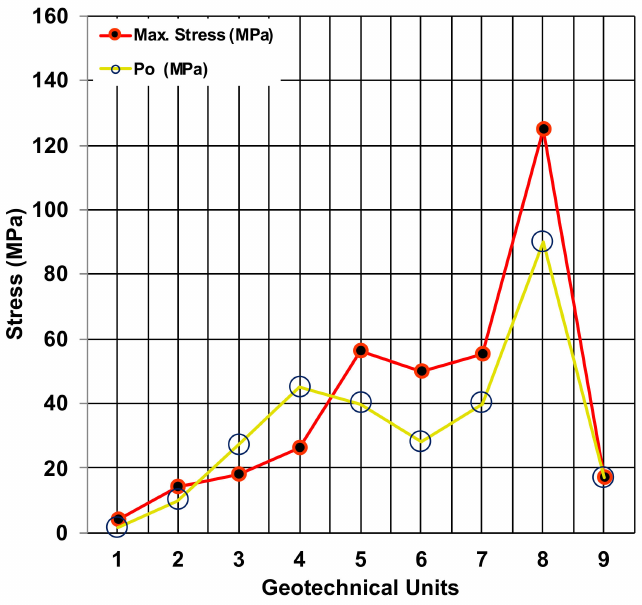
Figure 18. Maximum stress derived from the numerical analysis in RS2 [53] and p 0